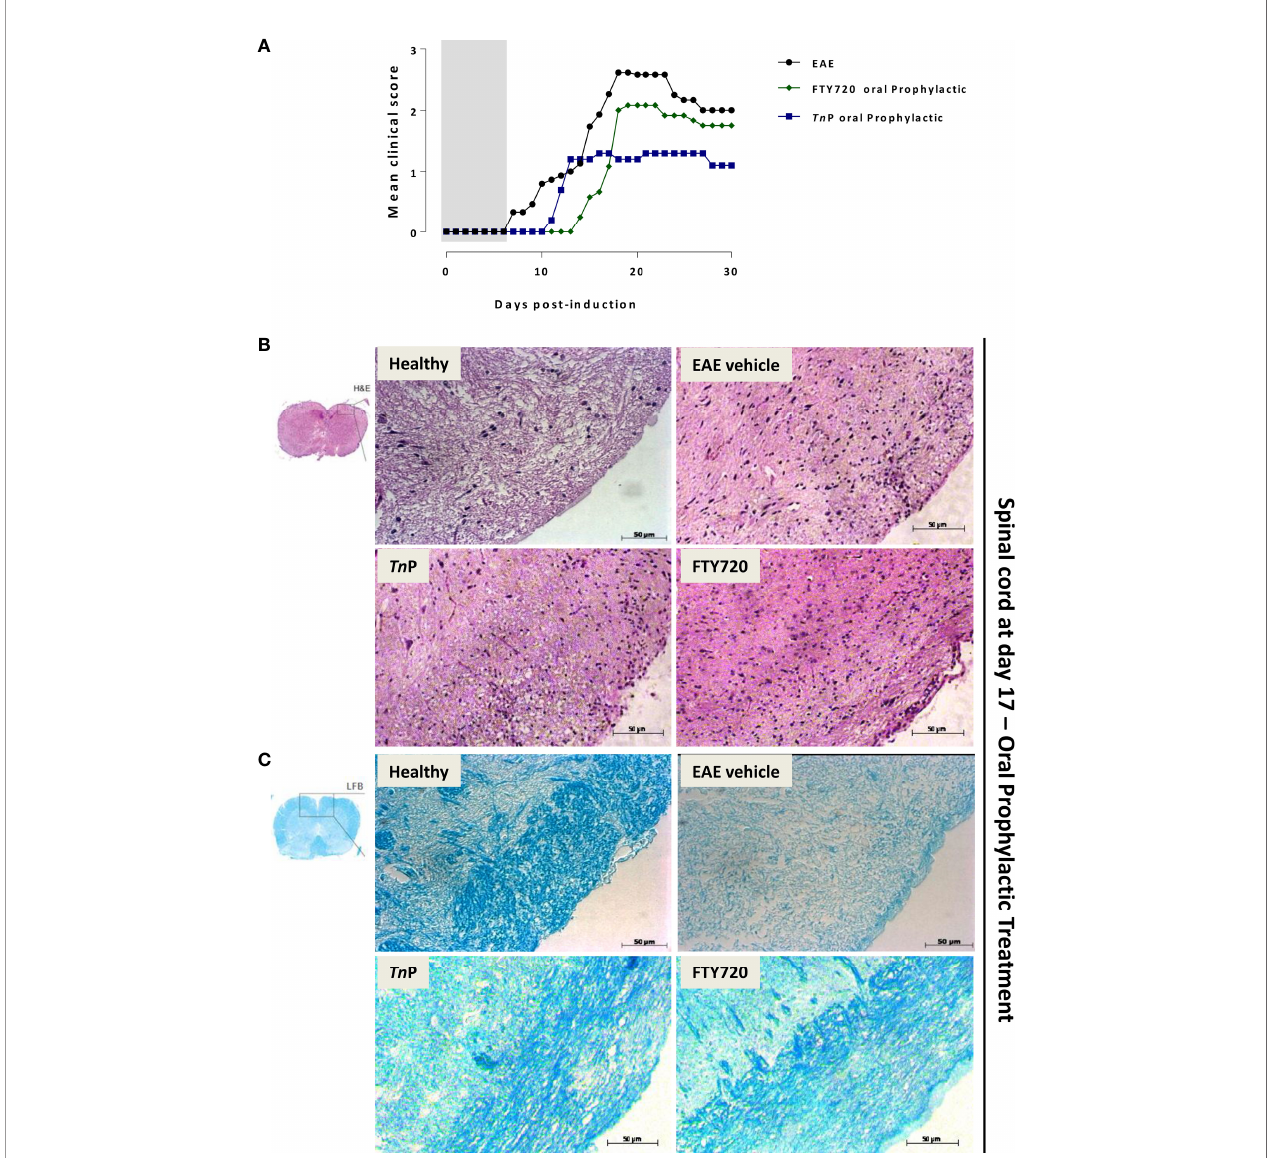
FIGURE 5 | Tn P applied orally is more effective in the control of disease than fi ngolimod. BL6 mice (n = 5/group) immunized with (MOG) peptide in incomplete Freund ’ s adjuvant added with M . tuberculosis were injected 2 times with Pertussis toxin after immunization. Mice were scored (0 – 5) daily for 30 d for evidence of clinical disease (A) . Mice were administered by oral gavage with Tn P at 3 mg/Kg or fi ngolimod at 0.3 mg/Kg diluted in 0.9% saline every other day starting at the day 0 of immunization until day 9 (prophylactic regimen). The EAE controls were injected with 0.9% saline alone (Vehicle). Spinal cords from healthy, vehicle-treated EAE, and EAE treated mice were removed on the peak of disease (17) and stained in with H&E (B) in the upper panels or Luxol fast blue in the lower ones (C) . Representative sections are